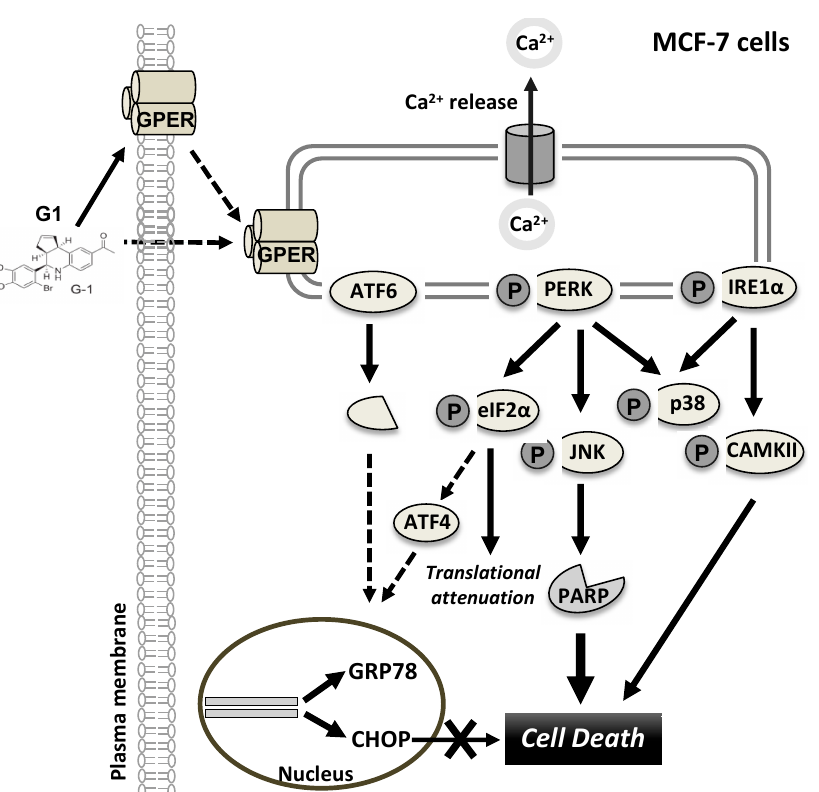
Figure 7. Model of the proposed mechanism of G1-induced cell death. G1 leads to a decrease of ER Ca 2+ stores in MCF-7 cells, and this event activates the UPR in MCF-7 cells, including the activation of IRE1 α , PERK and ATF6. The pro-survival UPR is activated exhibiting upregulation of GRP78 to assist the proper folding capacity of the ER and eIF2 α -phosphorylation to reduce translation of nascent proteins. However, pro-death UPR signaling plays a major role in G1-induced ER stress, which, in turn, regulates cell death. CHOP is upregulated but not involved in the G1-induced cell death machinery. In contrast, phosphorylation of both PERK and IRE1 α is implicated in G1-induced cell death. Phosphorylation of PERK stimulates the activation of downstream kinase JNK to directly induce apoptosis, while phosphorylation of IRE1 α induces phosphorylation of CAMKIII.